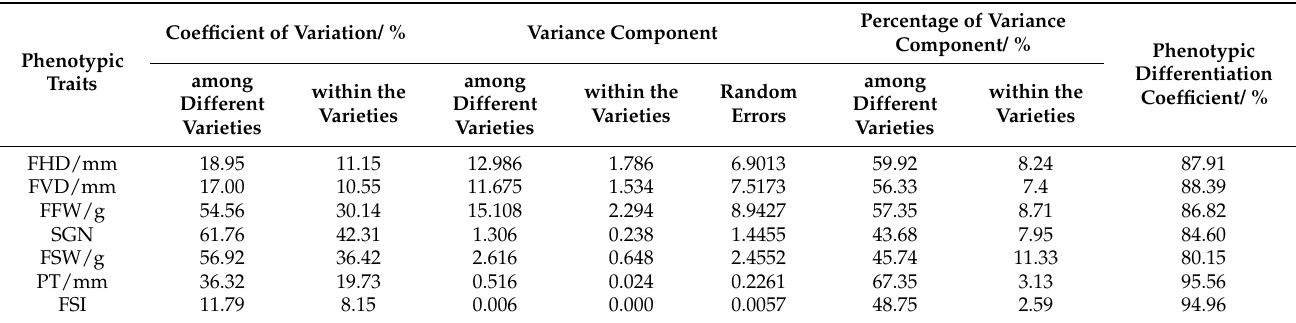
Table 4. Coefficient of variation, variance component, and phenotypic differentiation coefficient of C. oleifera in Guizhou.